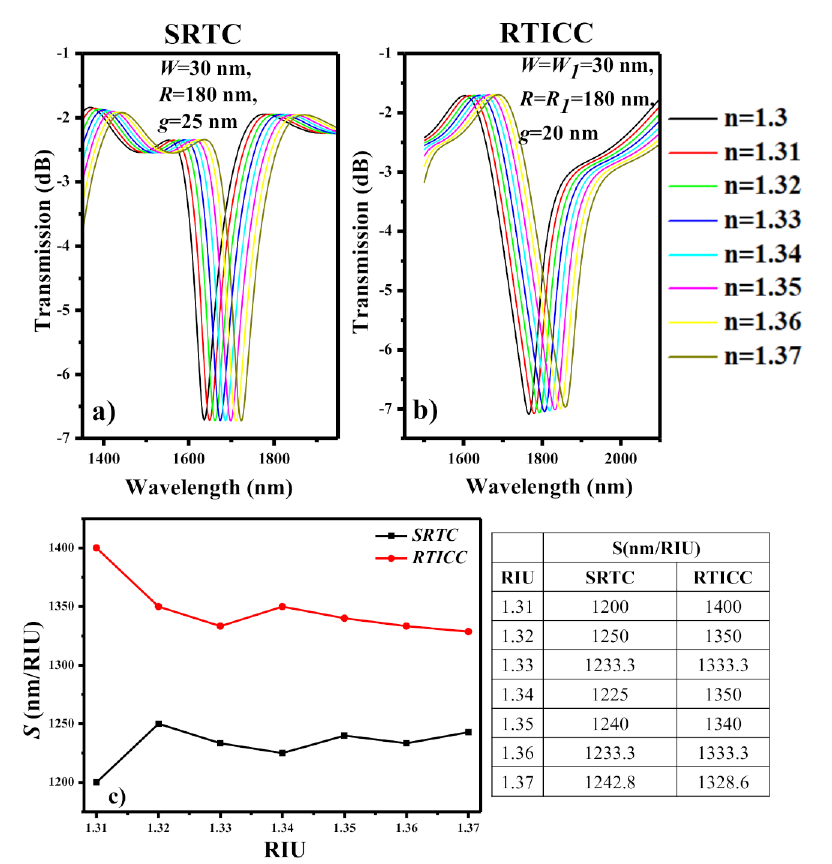
Figure 8. Transmission spectrum versus different ambient RI for ( a ) SRTC, ( b ) RTICC, ( c ) sensitivity versus